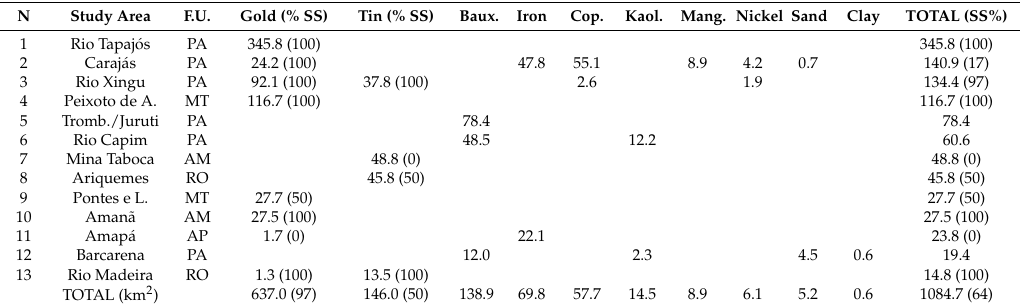
Table 4. Mining area in km 2 mapped with S2A images acquired in 2017 distributed over the study areas and specified by mineral type. For gold and tin, percentage of small-scale mining is shown between brackets. Federal Unit